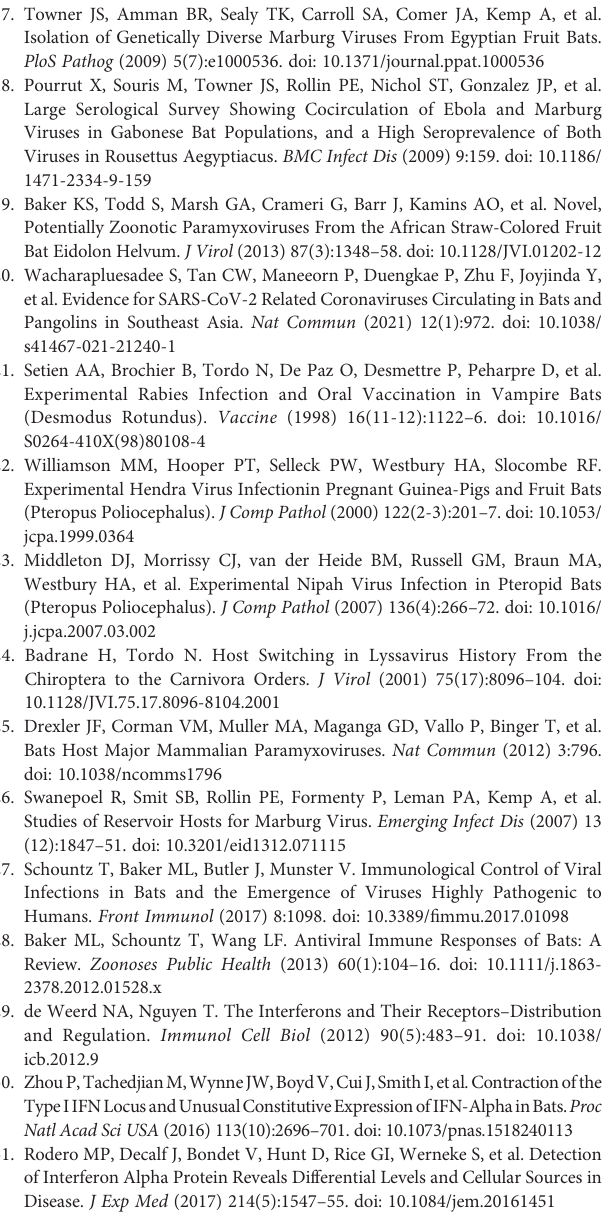
Supplementary Figure 4 | Viral inactivation decreases the af fi nity of the assay for bIFN a but not hIFN a 2c. hIFN a 2 assay response (AEB) as a function of IFN a concentrations for hIFN a 2c and bIFN a untreated or after viral inactivation. Supplementary Table 1 | All data available for each sample. Species, gender, GAPDH-normalized numberof IFN a 1, IFN a 2and IFN a 3 mRNAcopies, interferon a concentrations expressed as hIFN a 2c or bIFN a equivalent concentrations and notes available for each sample. Supplementary Table 2 | Primers and probes sequences. List of primers and probes used in RT-qPCR for bat IFN a 1, IFN a 2, IFN a 3 and GADPH, based on published data from Zhou et al. (30) for the bat IFN genes described for P. alecto and designed for this study for GADPH, from PrimerBLAST and available datas for GADPH gene in P. alecto and R. aegyptiacus